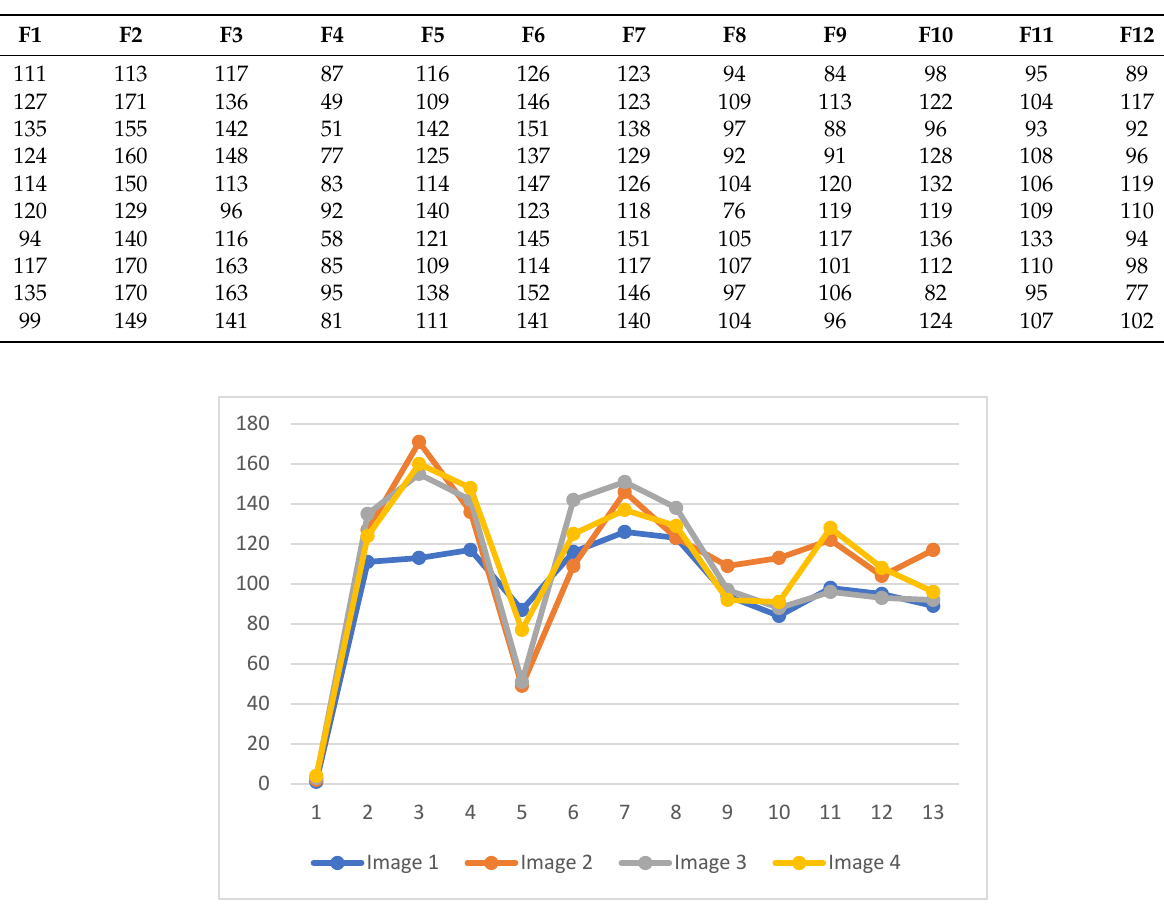
Table 1. Example of the concluding image vector.